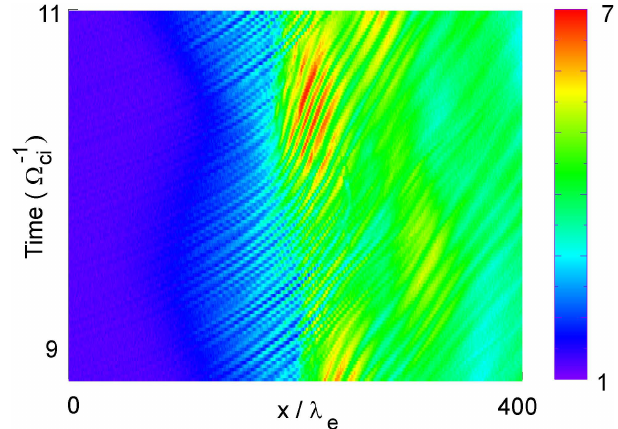
Fig. 2. Same as Fig. 1 for a smaller time